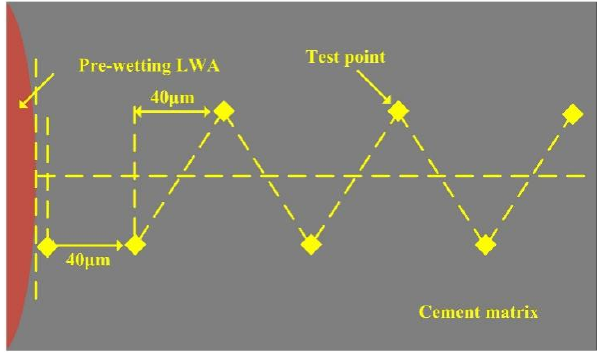
Figure 2. The microhardness test method of the interface transition zone.